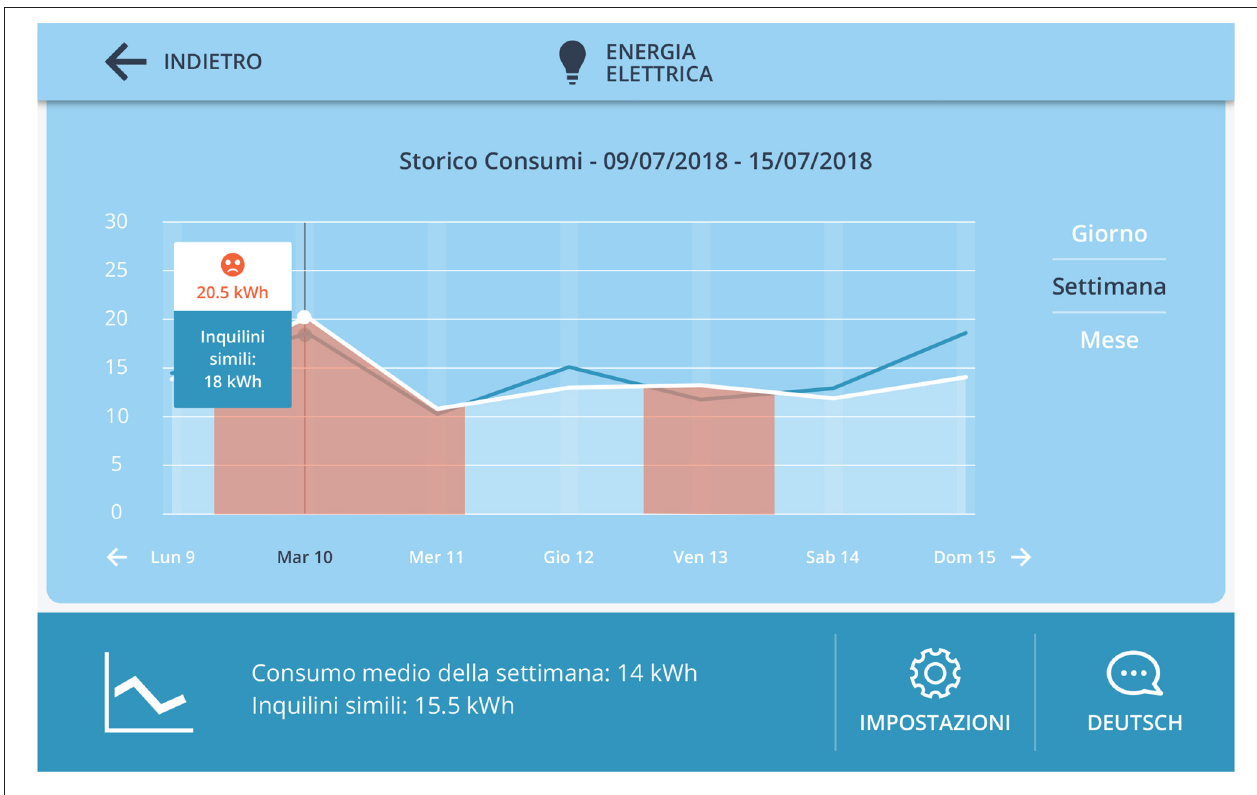
FIGURE 4 | Norms history display.